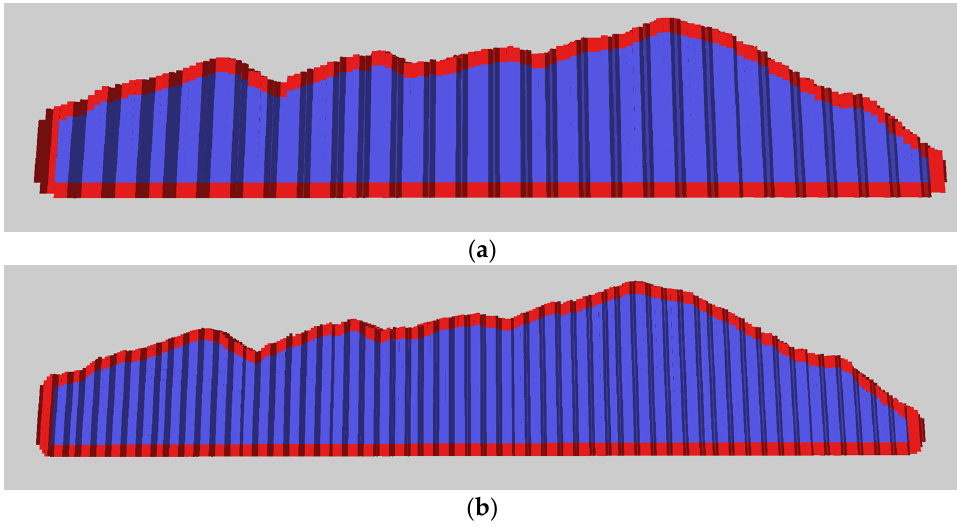
Figure 11. Cross-sectional views of the target area and its buffer with 80 m radius at the sphere grid levels of 18 ( a ) and 19 ( b ). Cells marked as the target area are shown in blue, and cells marked as the buffer are shown in red.